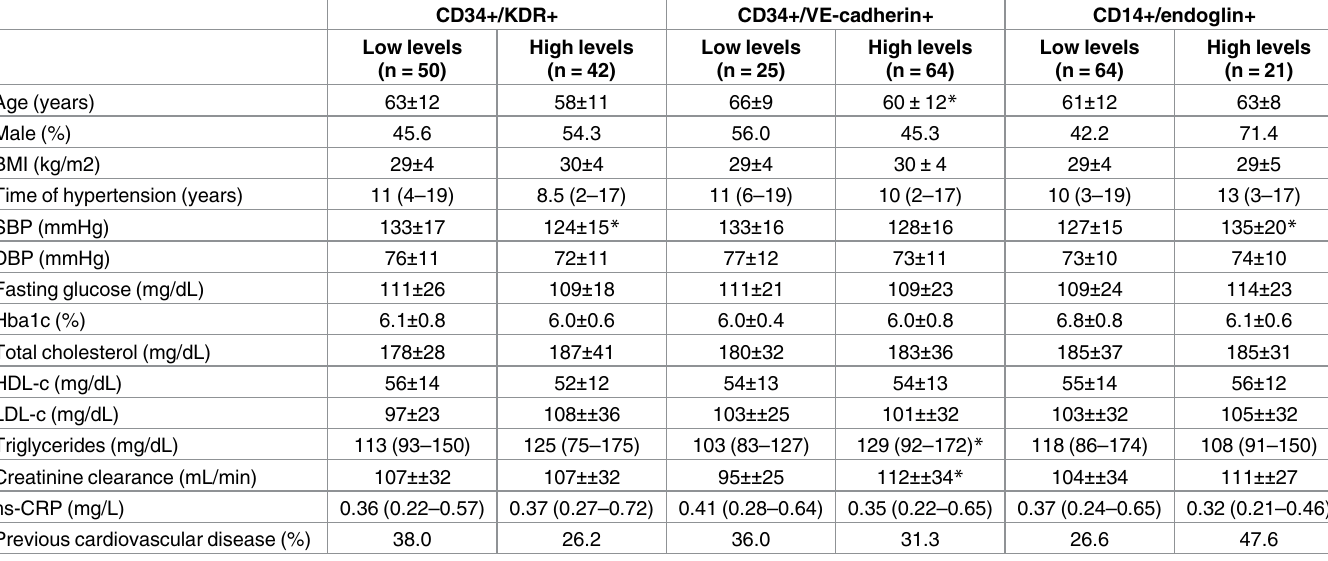
Table 2. Clinical-biochemical parameters of hypertensive patients regarding levels of CD34+/KDR+, CD34+/VE-cadherin+, CD14+/endoglin+cells. CD34+/KDR+ CD34+/VE-cadherin+